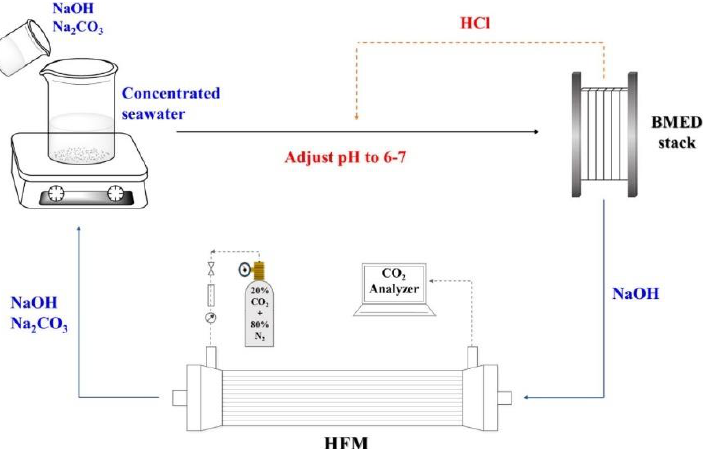
Figure 12. An illustrative scheme of the process of absorption of CO 2 using HFMC and BMED membranes filled with NaOH with permission of [140].